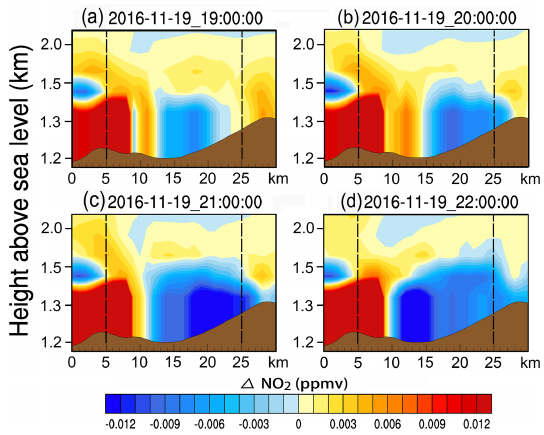
Figure 8. Cross section of the difference of modeled NO 2 air con- centrations between S1 and S2 model runs (S2 − S1) at 19:00, 20:00, 21:00, and 22:00UTC, 19 November 2016, along a transect across YWF, as shown by the red arrow line in Fig.